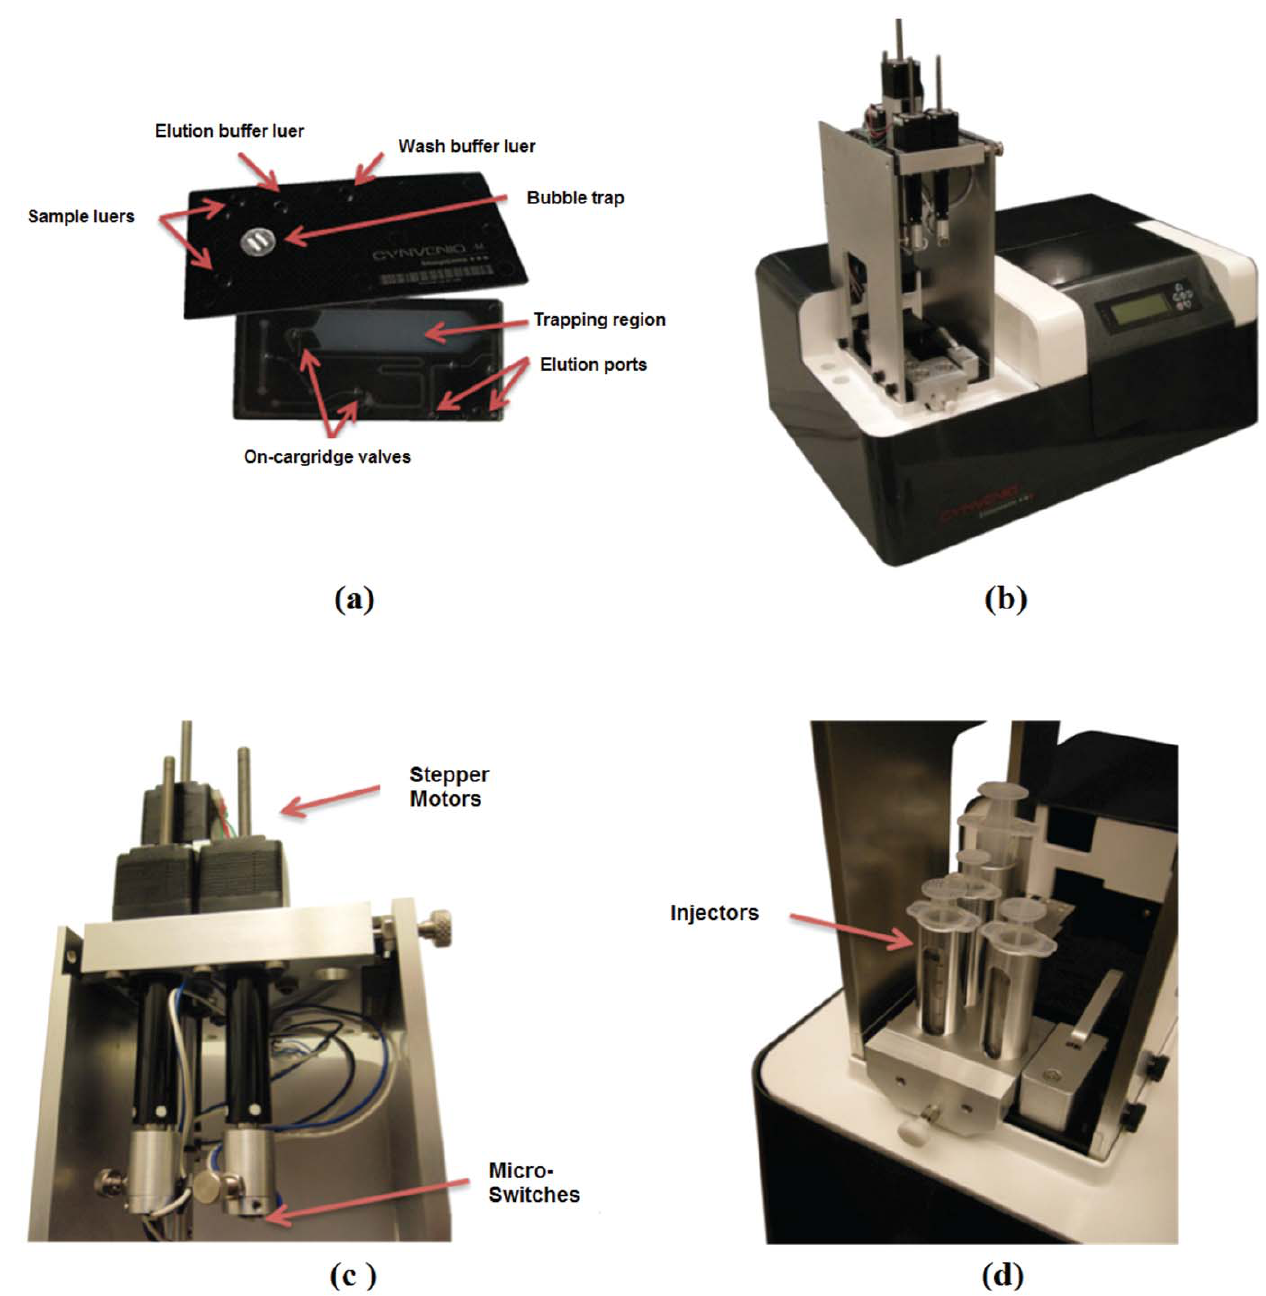
Figure 1. MMS Platform. A) MMS disposable cartridge with front side showing sample luer interfaces and backside showing separation region, on- cartridge valves and fluid path ways; B) automated MMS instrument with a volumetric control module for precise fluid injection speeds and